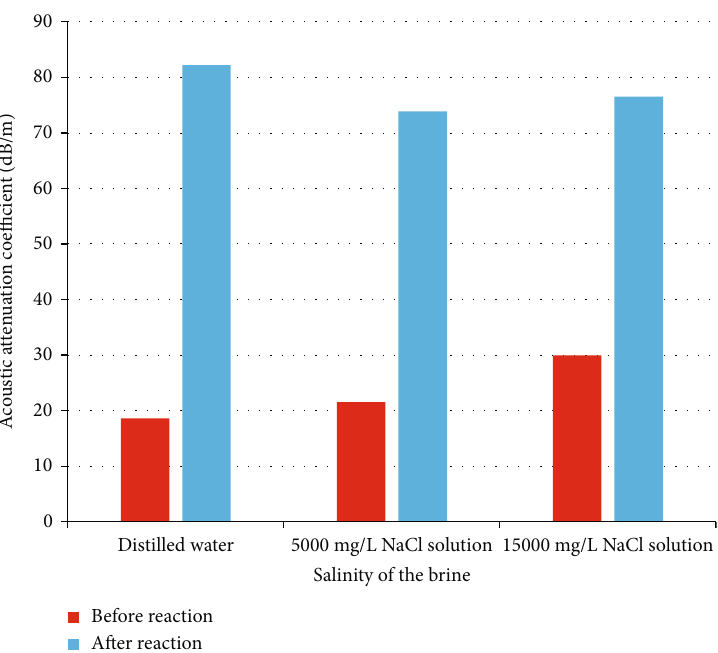
Figure 11: Acoustic attenuation coe ffi cient of shale before and after interaction with di ff erent salinity of brine for 48